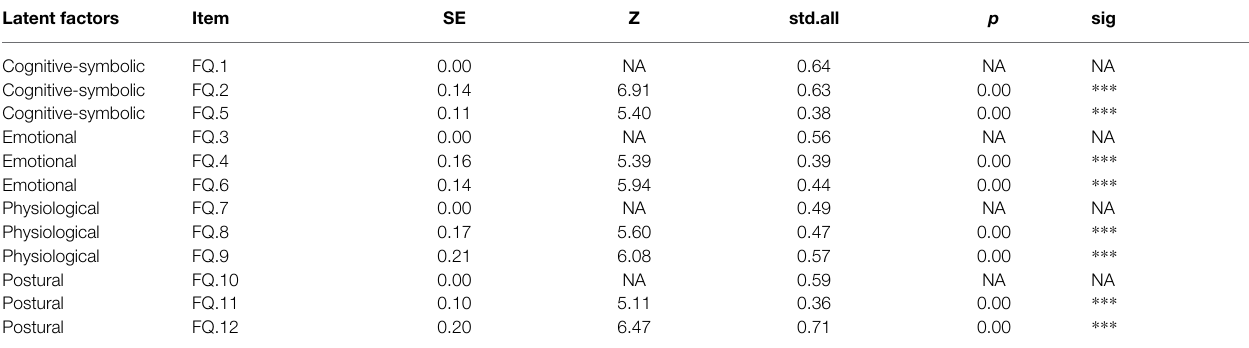
TABLE 1 | Functional anxiety assessment questionnaire (FQ) item saturation.